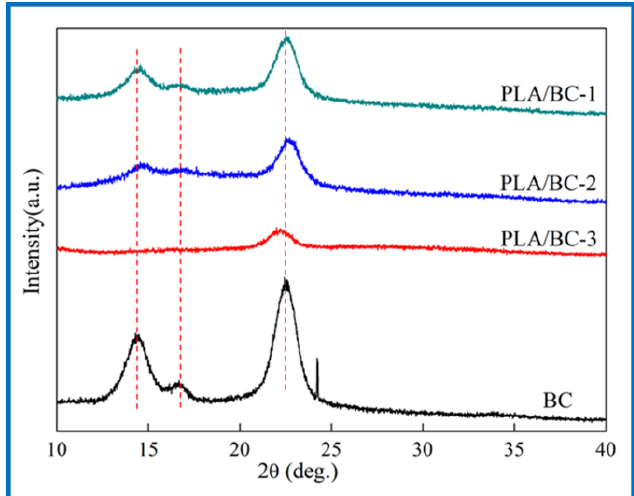
Figure 4. XRD spectra of 3D-printed PLA/BC scaffolds with three different surface microstruc-